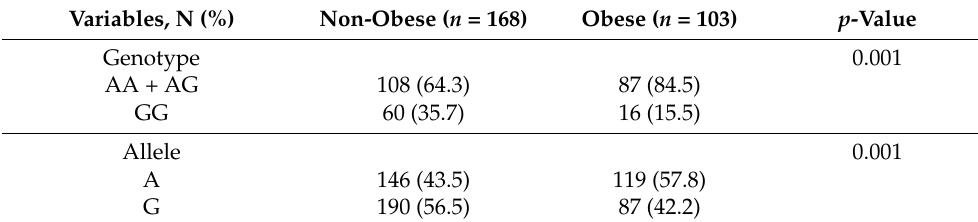
Table 3. Distribution of RANTES 59029A/G